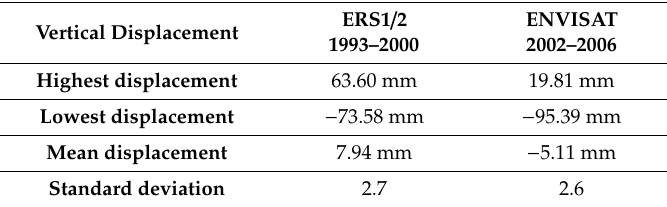
Table 2. DInSAR LoS measurements referred to the whole area.